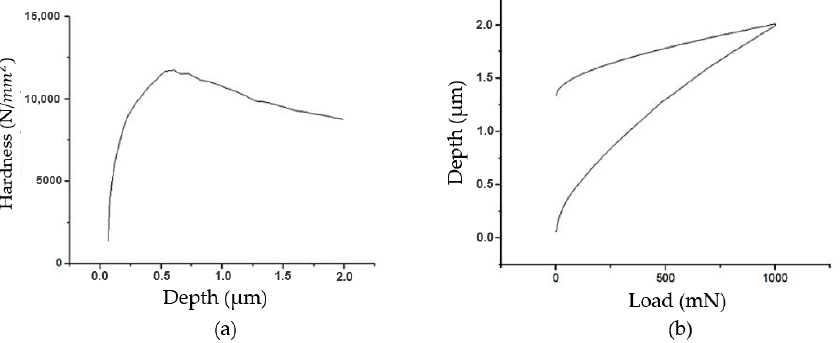
Figure 4. Example of the loading and unloading curves for the 1.2379 + AlTiN-TiSiN sample with a maximum load of 1000 mN. The image on the left ( a ) represents the measured hardness value while the load increases and the indenter penetrates into the surface of the sample, thus increasing the monitored depth value. The image on the right ( b ) instead represents the monitoring of the indenter’s position against the applied load.